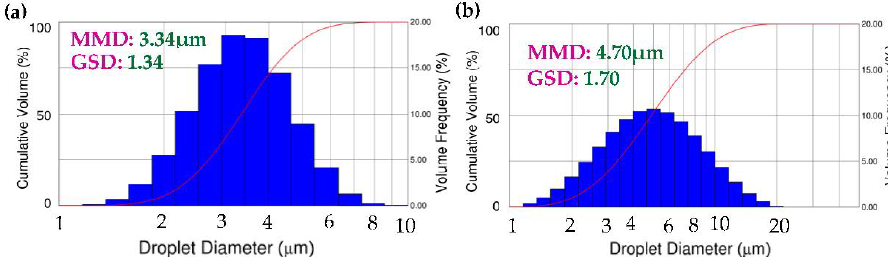
Figure 8. Figure 8. Diameter and size distribution of ( a ) water droplets produced by a 2 MHz 4-Fourier horn